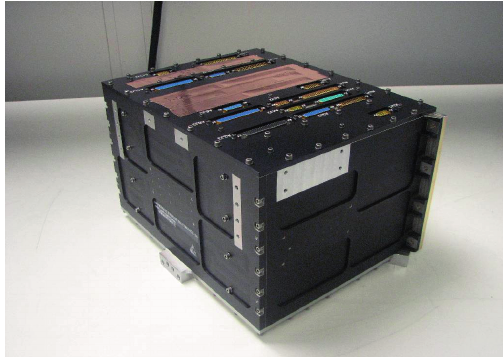
Figure 9. The instrument support electronics without cabling.